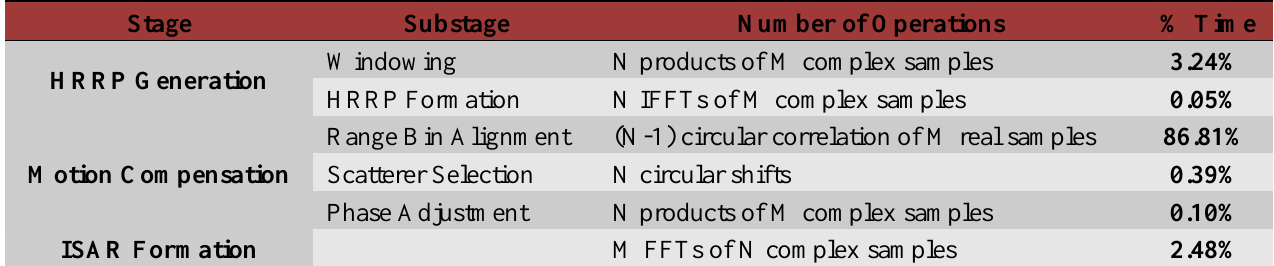
Table 2. Operations needed to obtain an ISAR image.